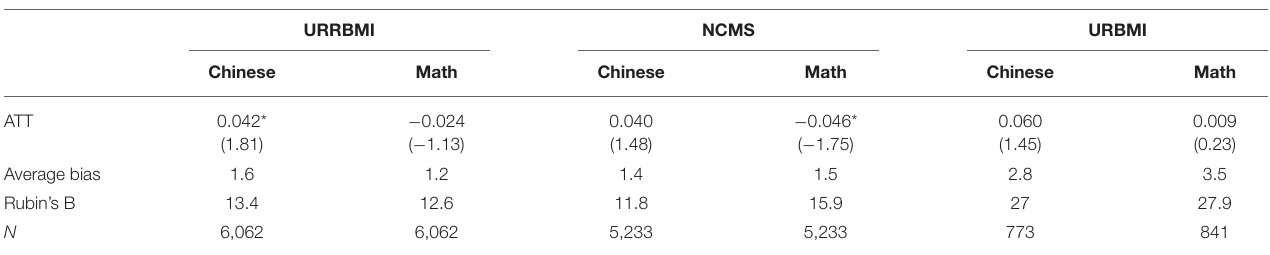
TABLE 4 | PSM regression.